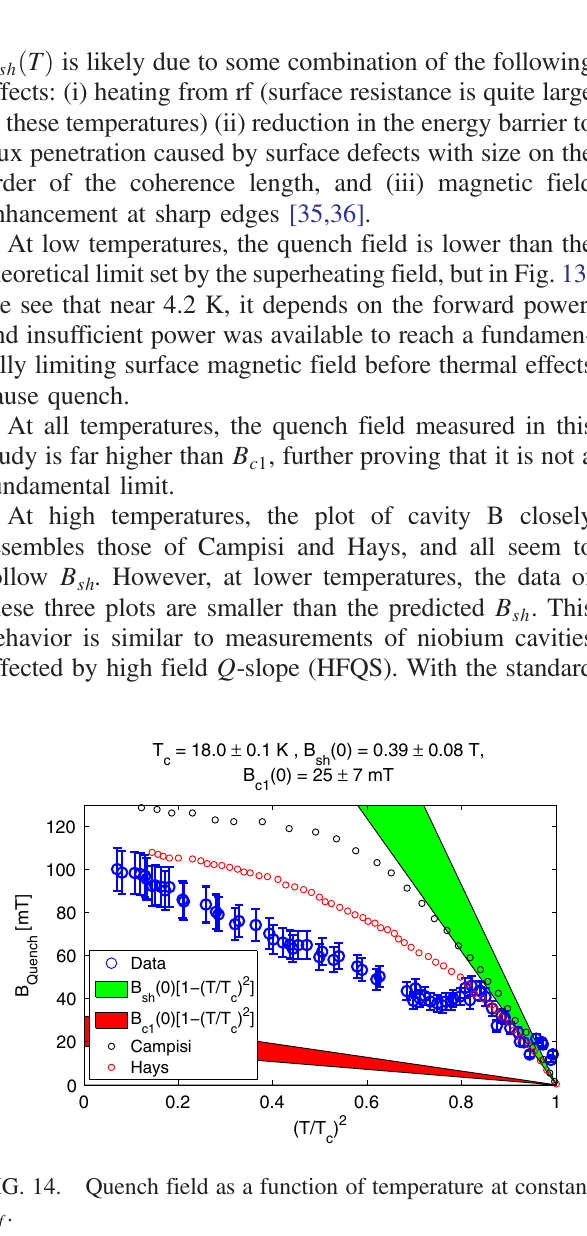
FIG. 13. Reducing the forward power from the klystron increases the time to quench and decreases the quench field. The red curve is a one-parameter fit to the data based on a simple thermal